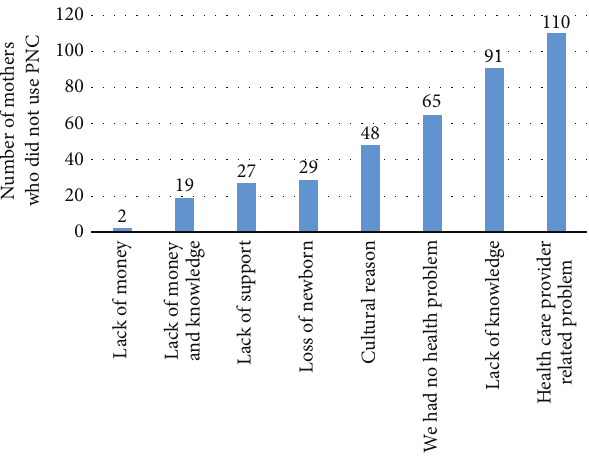
Figure 2: Reasons for not attending postnatal care services given by the study participants at Debre Markos town, Northwest Ethiopia, December, 2014 ( 𝑛 = 391